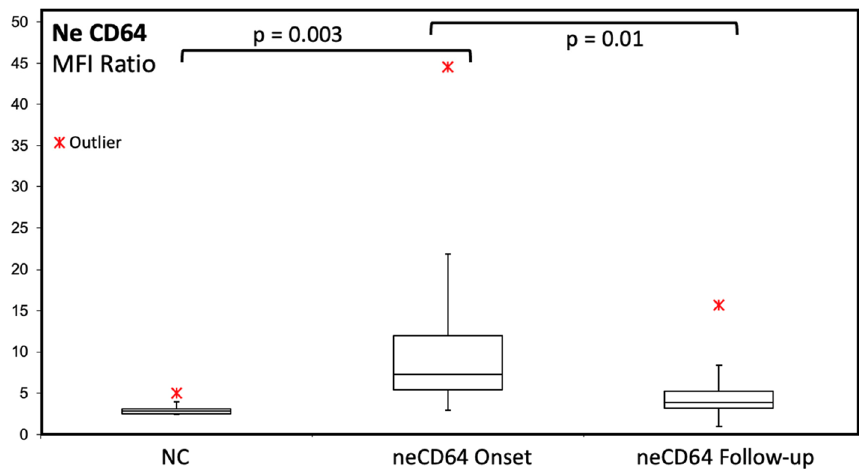
Fig. 2 Expression of neutrophil CD64 at disease onset and during the follow-up. A mild upregulation of neCD64 is observed in the majority of patients, while very high values were detectable only in patients with overt bacteremia and sepsis